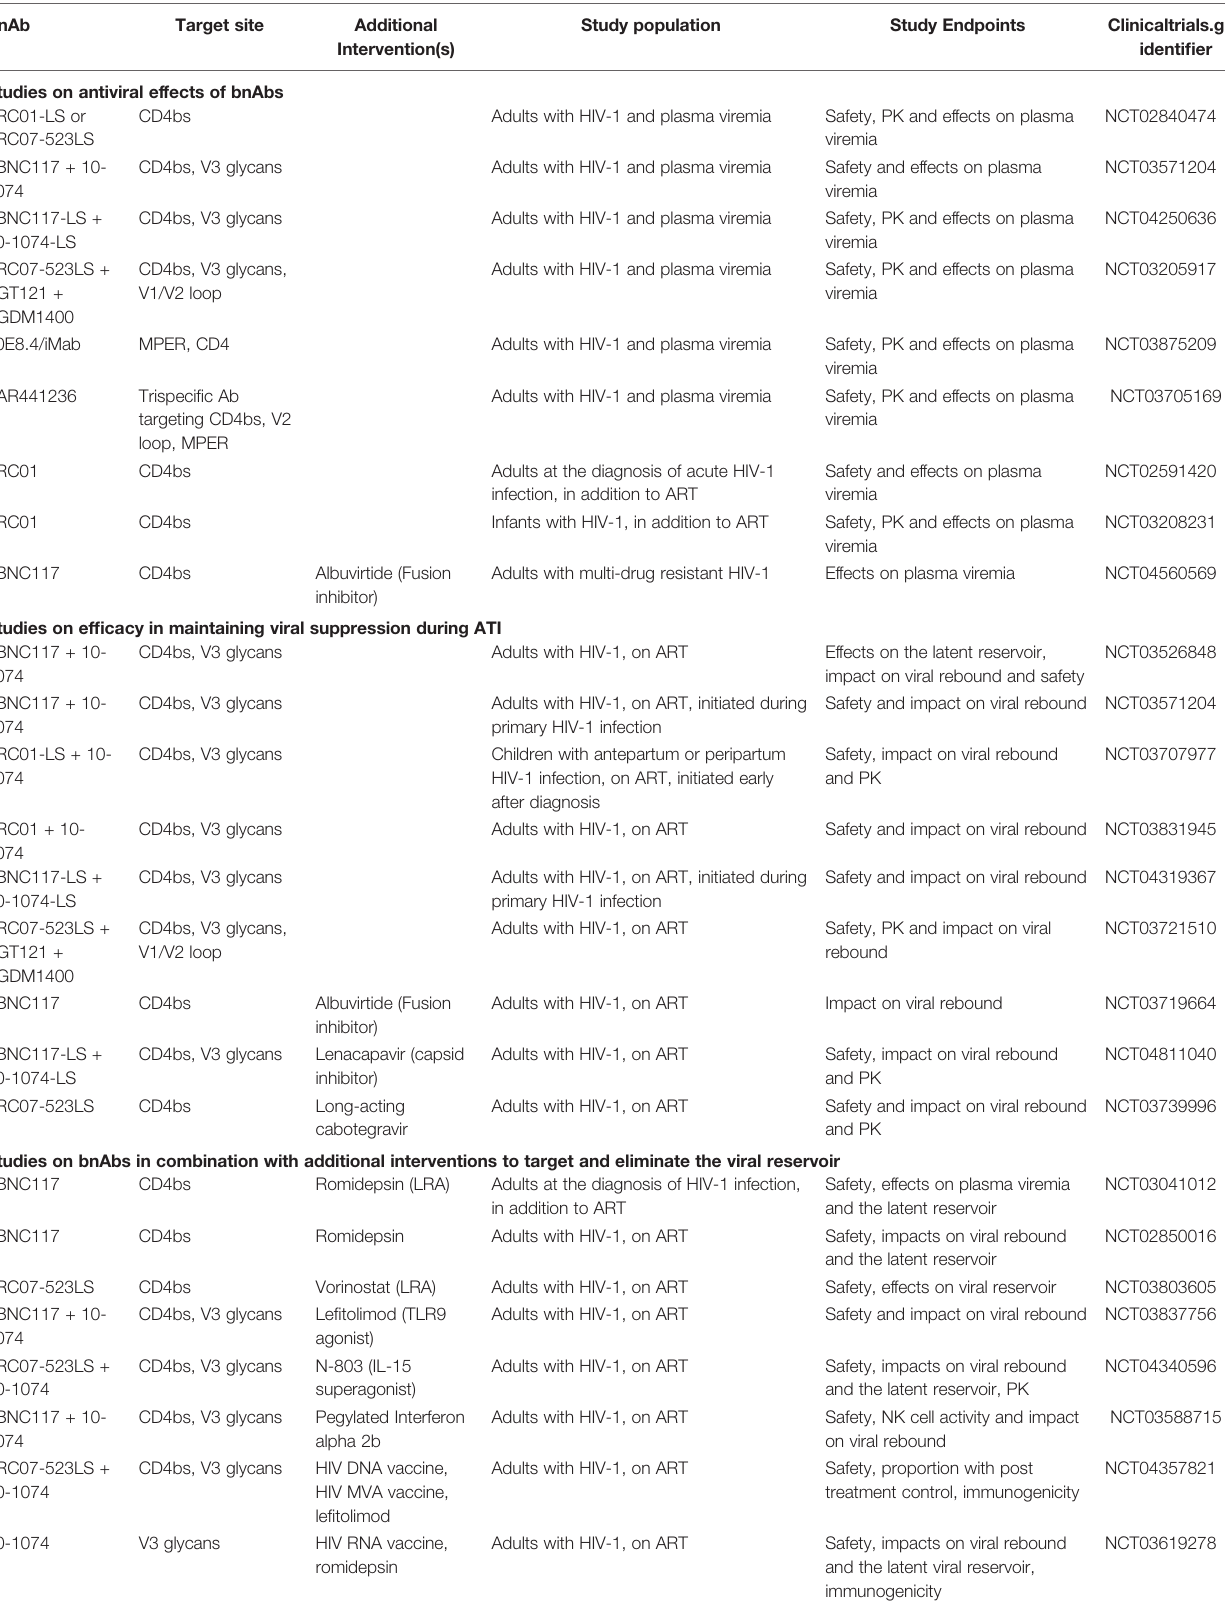
TABLE 1 | Ongoing clinical trials of bnAb as part of HIV-1 therapeutic or remission